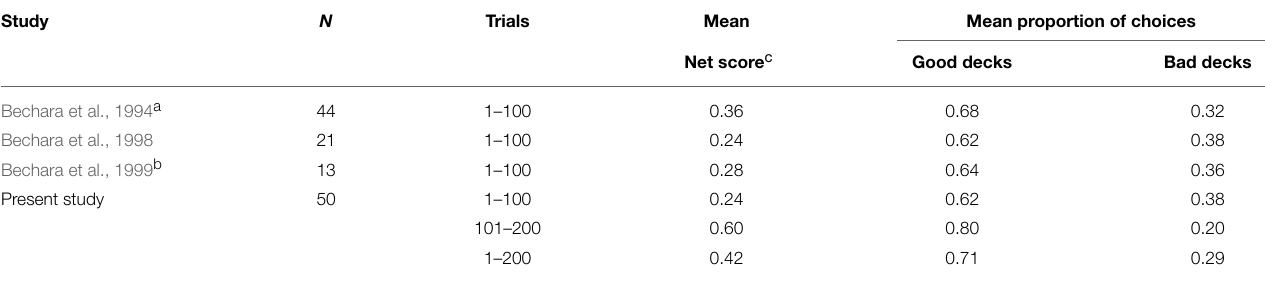
TABLE 1 | Mean net scores (expressed as proportions of number of trials) and aggregated deck preferences in Bechara et al.’s studies and in the present study. Study N Trials Mean Mean proportion of choices